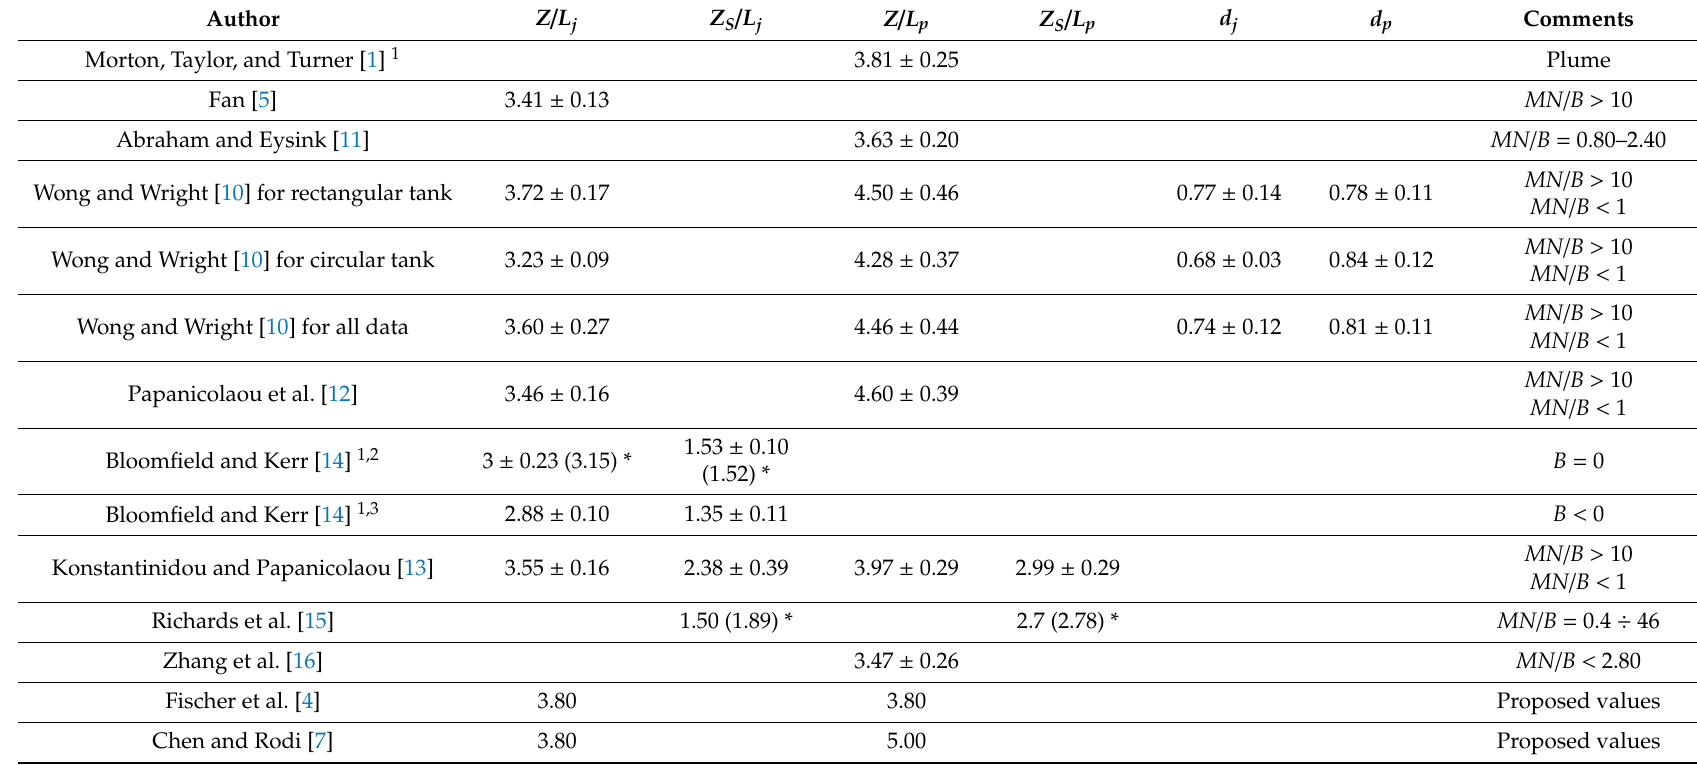
Table 2. Evaluation of the dimensionless parameters from earlier